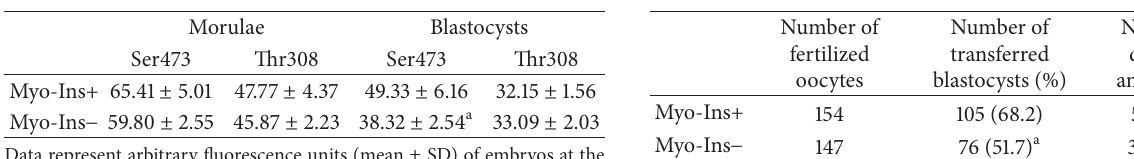
Table 2: Mouse development after IVF and exposure of preimplan- tation embryos to